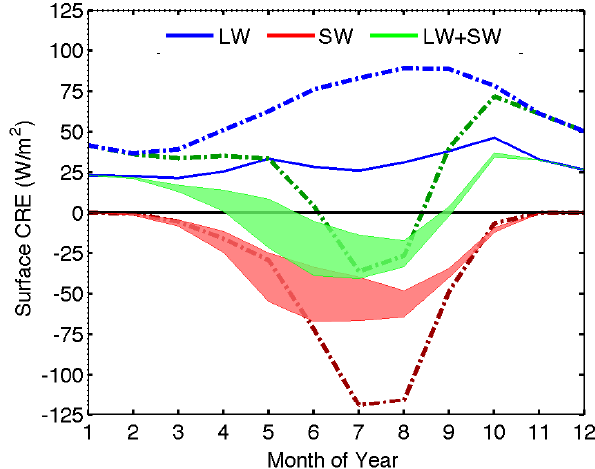
Fig. 5. Annual cycle of the long-, shortwave and net cloud radiative effects over the Arctic Ocean based on 2B-FLXHR derived from CloudSat (solid lines and areas) and on ERA-Interim (dash-dotted lines). The satellite shortwave data has been corrected for the pres- ence of sea ice as described in the text, and the shaded areas depict the sensitivity to these choices. ERA-Interim here uses its native surface albedo, which on average is lower than the assumptions used for